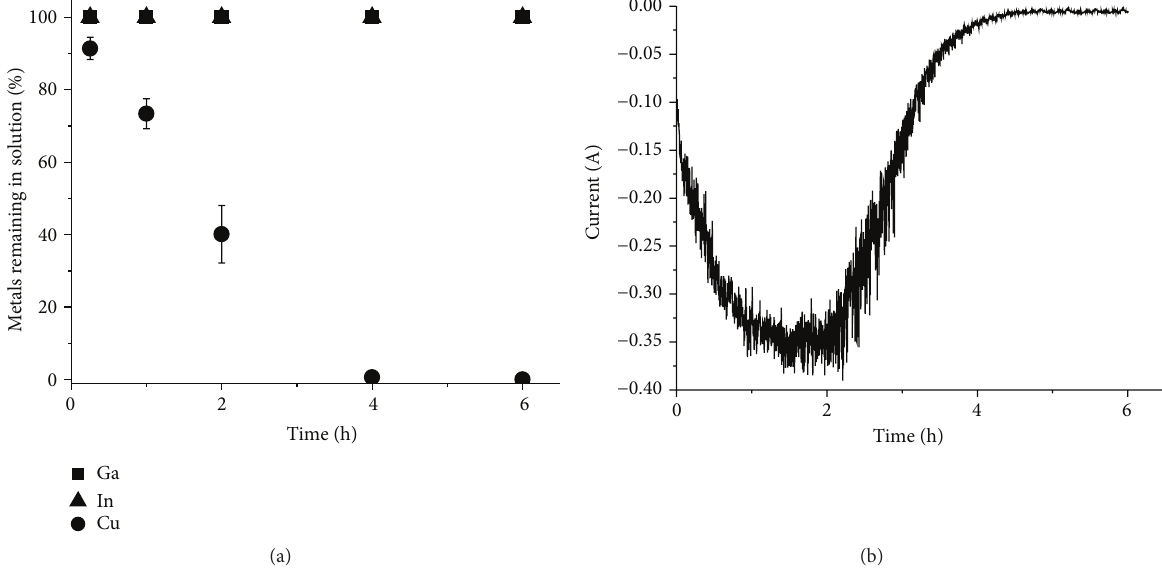
Figure 10: Electrochemical separation of copper from a solution prepared by dissolving prechlorinated CIGS waste material in 1M HCl (Solution 3). (a) The metal concentration in the solution relative to the original concentration as a function of time. (b) The current passed though the circuit as a function of